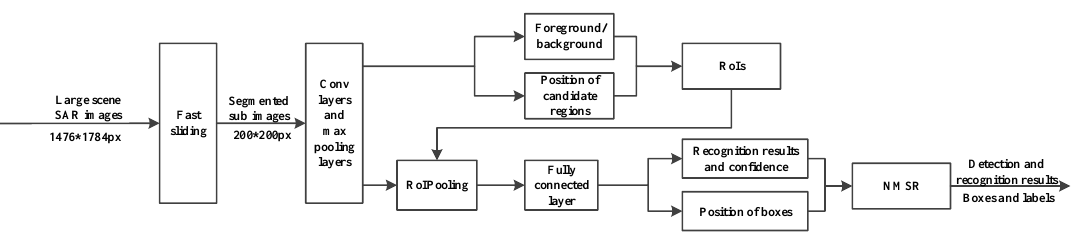
Figure 1. Flow chart of our model. (NMSR: non-maximum suppression among regions; SAR: synthetic aperture